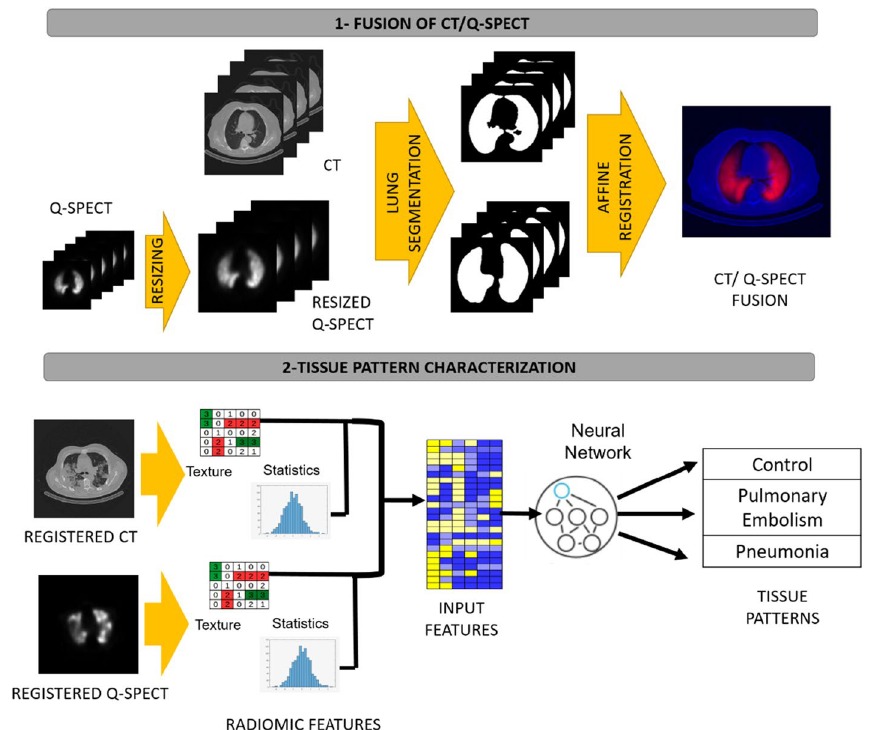
Fig. 1 Illustrative flowchart of the stages of the system